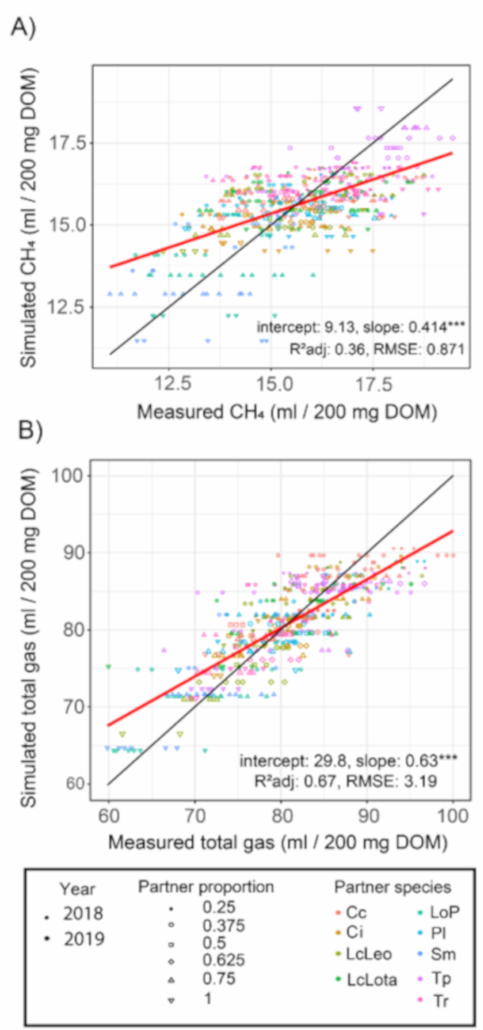
Figure 2. Comparison of simulated vs. measured data for methane production ( A ) and total gas production ( B ). Significance levels are: *** p ≤ 0.001). Abbreviations are as follows (in